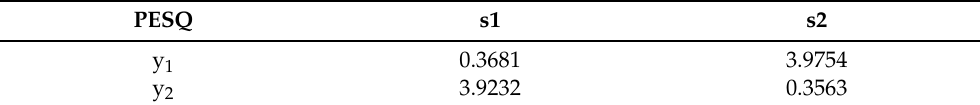
Table 3. PESQ value between each separated speech and source speech signal.